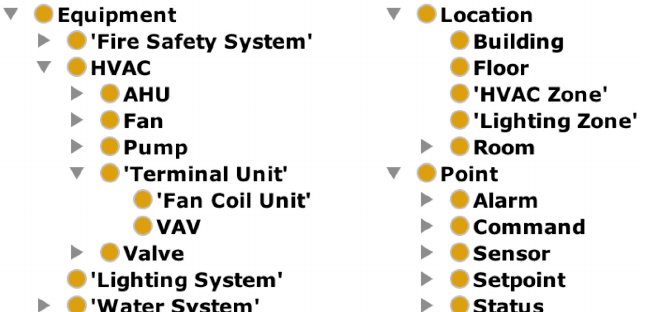
Figure 8. A subset of the Brick class hierarchy [132] (Reprinted from Elsevier Applied Volume 226,